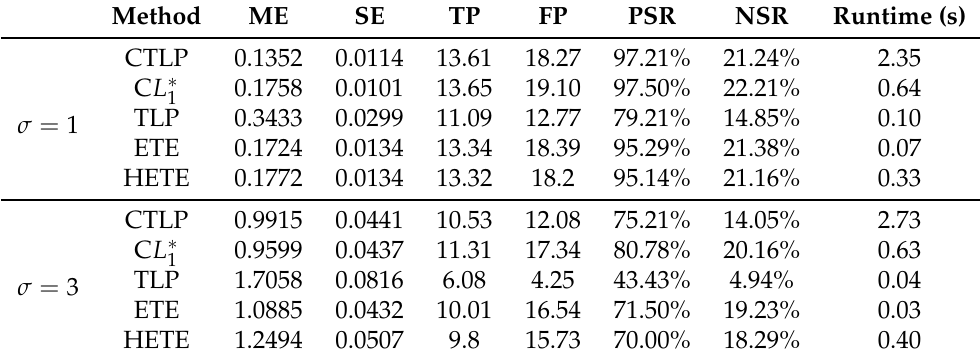
Table 5. The comparison of four methods in the case of n < p , independent correlation matrix.